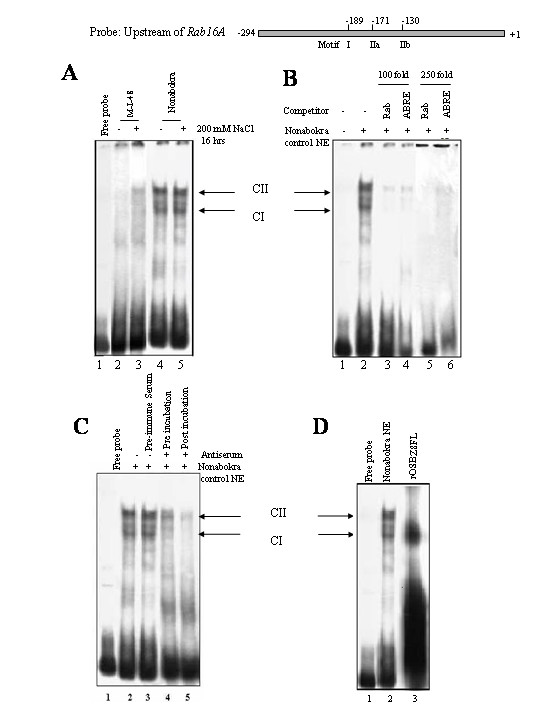
Comparative EMSA of nuclear extracts with [32P]-Rab16A promoter (300 bp natural promoter, containing motif I, motif IIa and IIb) as probe. A. Formation of two different complexes, C1 and CII (arrow marked) differing in their mobility was observed when equal amount of nuclear extract (20 μg) from M-1-48 and Nonabokra were incubated with equal amount of [32P]-labeled Rab16A promoter (80,000 CPM) as probe. Complex formation was extremely low and inducible in M-1-48 (lane 2 and 3) whereas both complexes were high and constitutive in Nonabokra (lanes 4 and 5). B. Specificity of the complexes formed in EMSA, as shown by the competition by non-labeled Rab16A at 100 fold molar excess for CI complex (lane 3) and at 250 fold molar excess for CII complex. 100 fold excess of 1XABRE (lane 4) showed competition with CI complex formation, suggesting motif I is equivalent to ABRE. C. Nuclear extract (20 μg) from Nonabokra control lamina showed the formation of CI and CII with [32P]Rab16A promoter (lane 2). The figure shows that both pre- and post-incubation (lane 4 and 5) with antiserum (before and after the addition of [32P]-Rab16A promoter) abolished CI, the faster migrating complex. Incubation with equal concentration of pre-immune serum shows no such effect (Lane 3). D. EMSA of [32P]Rab16A promoter with the 43 kD recombinant 6X His-OSBZ8FL protein shows the formation of a single complex and the shift was equal to CI formed by the nuclear extract and [32P]Rab16A (Lane 3). Lane 2 shows the usual formation of CI and CII with Nonabokra laminar nuclear extract.